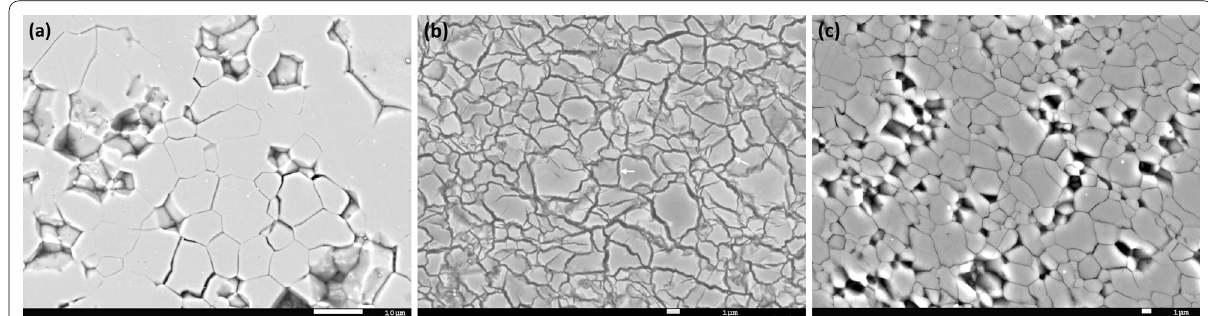
Fig. 4 Back-scattered electron (BSE) images showing back-transformation microstructures in ringwoodite. a Polycrystalline microstructure of the starting material (ringwoodite). b Fine-grained olivine (darker regions indicated by white arrows) forms reaction rims along grain boundaries of parental ringwoodite grains in the partially back-transformed sample recovered at 1.2 GPa and 645 °C (Run M2893). c Polycrystalline olivine after the completion of the back-transformation at 6.6 GPa and 800 °C (Run